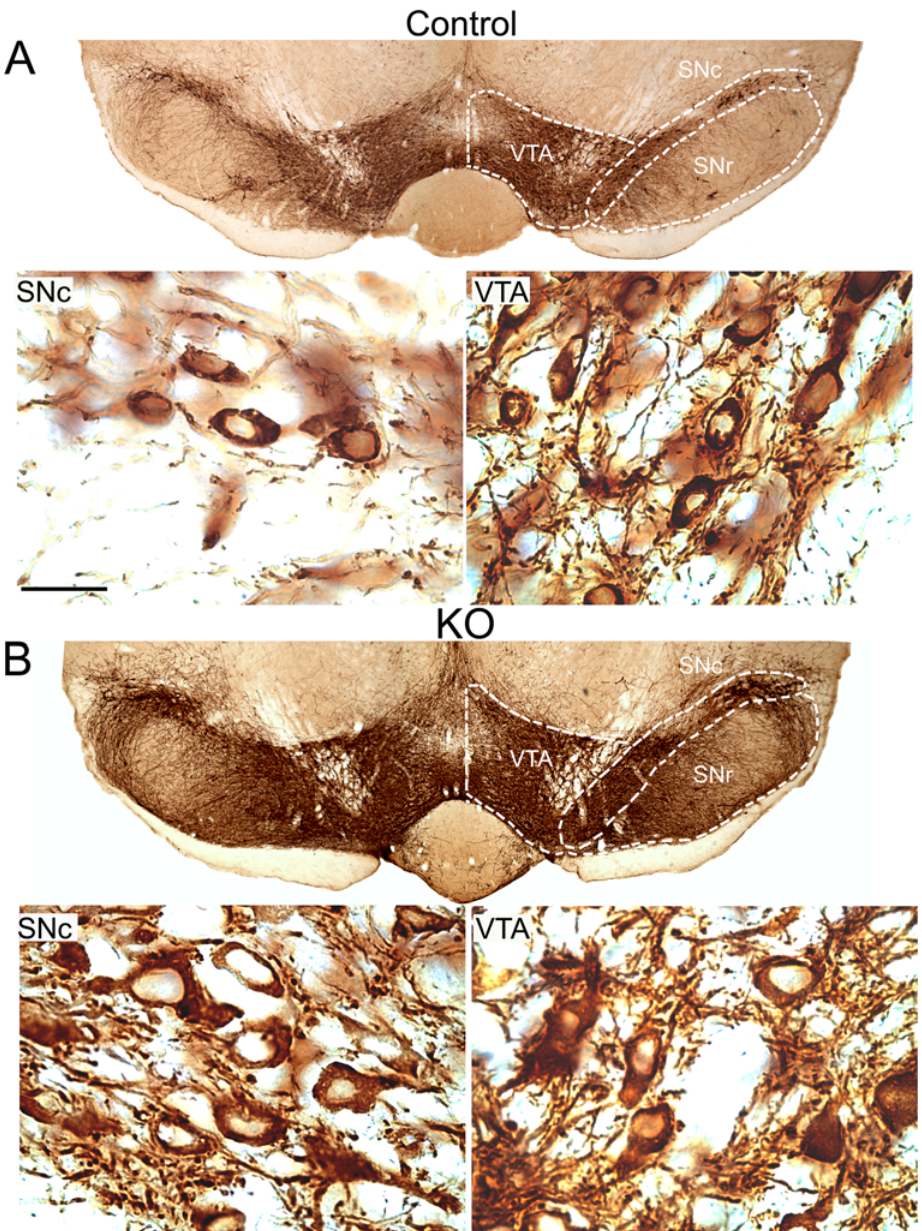
Figure 2. Pten deletion alters DA neurons in the ventral midbrain. Sections processed for TH immunostaining show a significant increase in the number of TH immunopositive profiles in the substantia nigra compacta (SNc) and ventral tegmental area (VTA) of adult Pten KO animals when compared to controls (A and B). The total area covered by TH positive staining was significantly increased in Pten KO animals when compared to controls. Increase in the size of the mesolimbic and nigrostriatal projecting structures are due not only to an increase in the number of DA neurons, but also to an increase in neuronal size and in dendritic outgrowth (see inserts in A and B). Sections correspond to Bregma -3.16 mm with reference to Franklin and Paxinos (1997). Scale bar corresponding to high magnification, 250 m m, and low magnification, 25 m